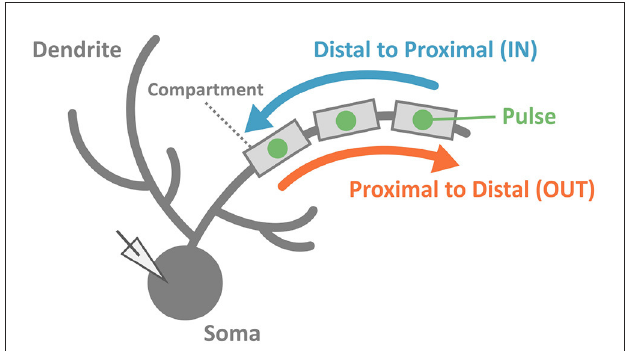
FIGURE2 Schematic of stimulation and recording in the simulation. We injected two sequences consisting of multiple pulses with the same strength but different input orders (IN or OUT). Soma membrane potentials were recorded to investigate whether the PC model could discriminate spatiotemporally different pulse sequences. In this study, we considered spiking or not spiking in the soma for classifications of